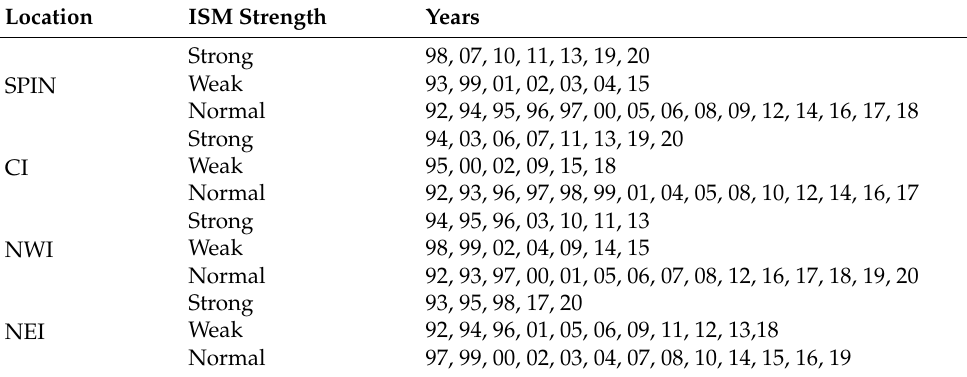
Table 1. A list of years with strong, weak, and normal rainfall over SPIN, CI, NWI, and NEI for the period 1992–2020. The method to define the strength of JJAS rainfall over the IMD regions is described in Section